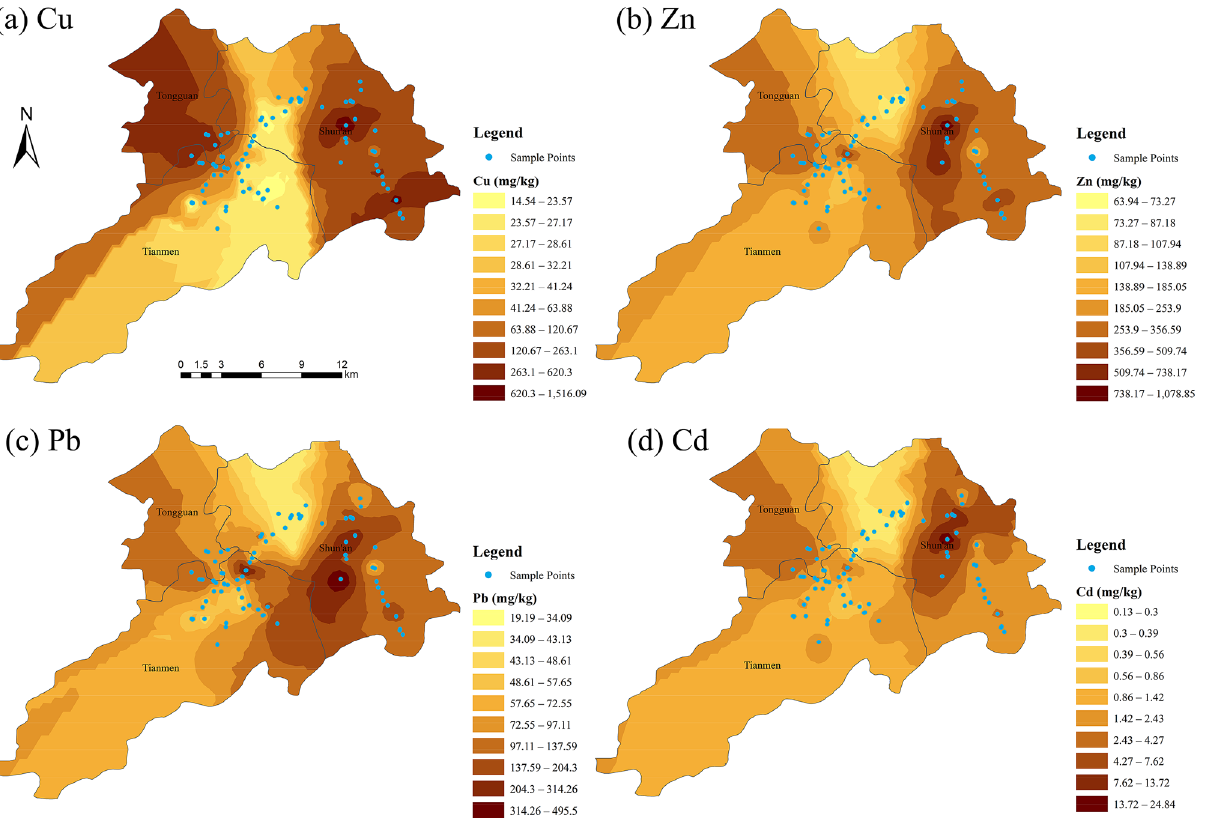
Figure 3. Spatial distribution maps of ( a ) Cu, ( b ) Zn, ( c ) Pb, and ( d ) Cd in the study area. The base map was generated in ArcGIS10.2 (Esri, Redlands, CA, USA, 2014) (https:// www. esri. com/ en- us/ arcgis/ about- arcgis/ overv